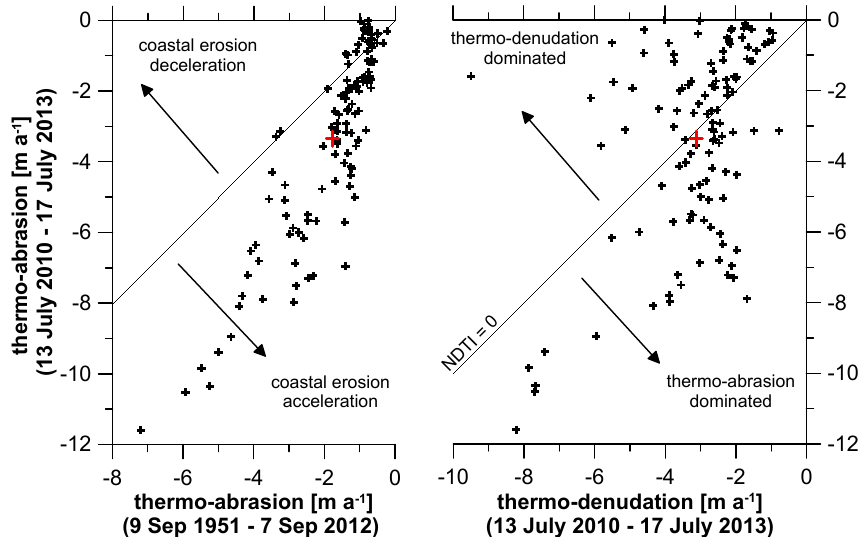
Figure 11. Point by point coastal thermo-erosion over time, red crosses indicate mean values. Left: historical thermo-abrasion (TA) from 1951 to 2012 in relation to current changes from 2010 to 2013, showing TA acceleration at 95 out of 118 coastal segments. Line of equal rates. Right: current thermo-denudation (TD) in relation to TA, showing TD- and TA-dominated coastal erosion regimes were around the same frequency. Virtual normalised difference thermo-erosion index (NDTI) zero-line for differentiation.